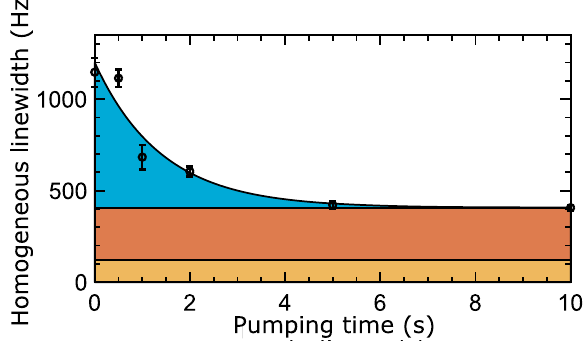
FIG. 4. Optical homogeneous linewidth Γ transition at − 4 . 6 GHz as a function of pumping time under DEOP. Optical pumping is set at − 1 . 44 GHz [see Fig. 3(a)]. The area under the curves represents contributions to Γ 171 Yb 3 þ in site 2 (blue), other centers including 171 Yb 3 þ in site 1 (orange), and the excited-state lifetime (yellow). The line drawn through experimental data points is a guide to the